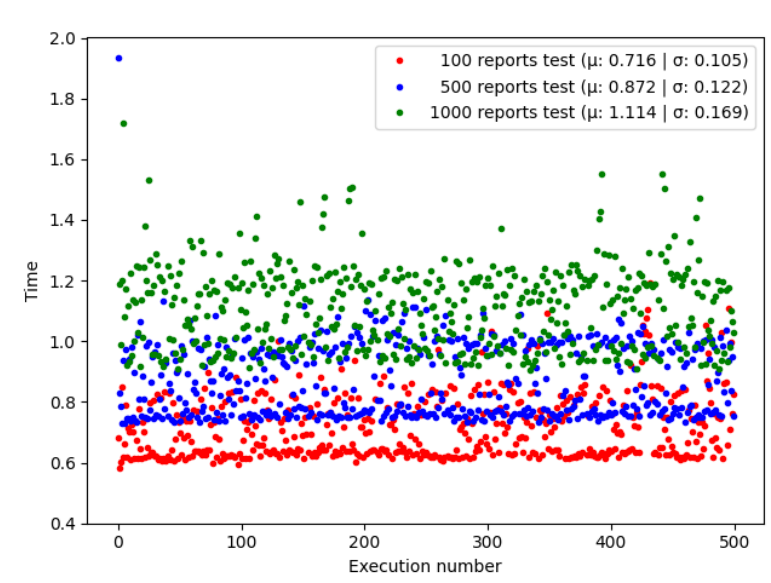
Figure 5. Comparison of time required to query multiple reports at once: